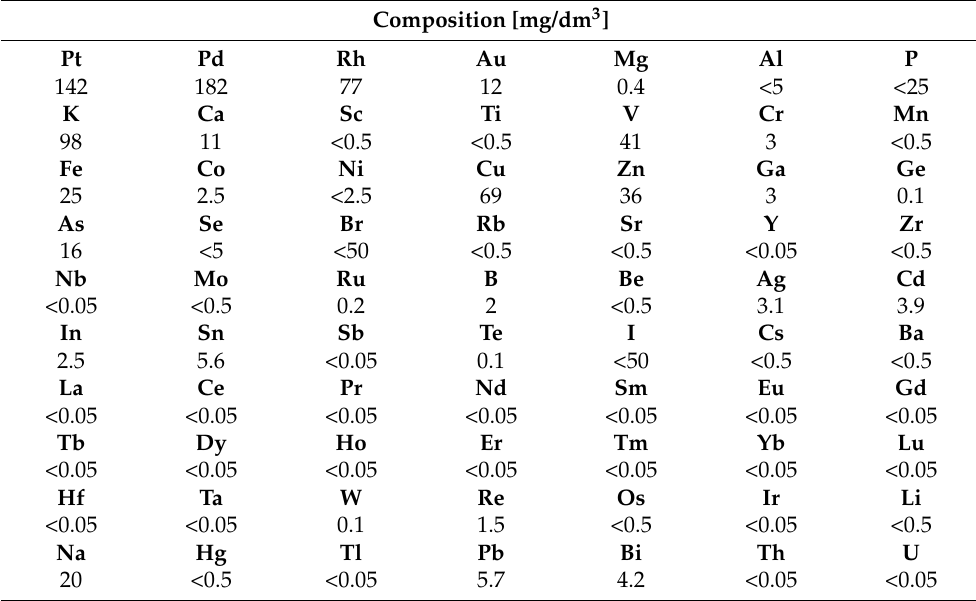
Table 2. Composition of the technological solution obtained by the semiquantitative analysis.